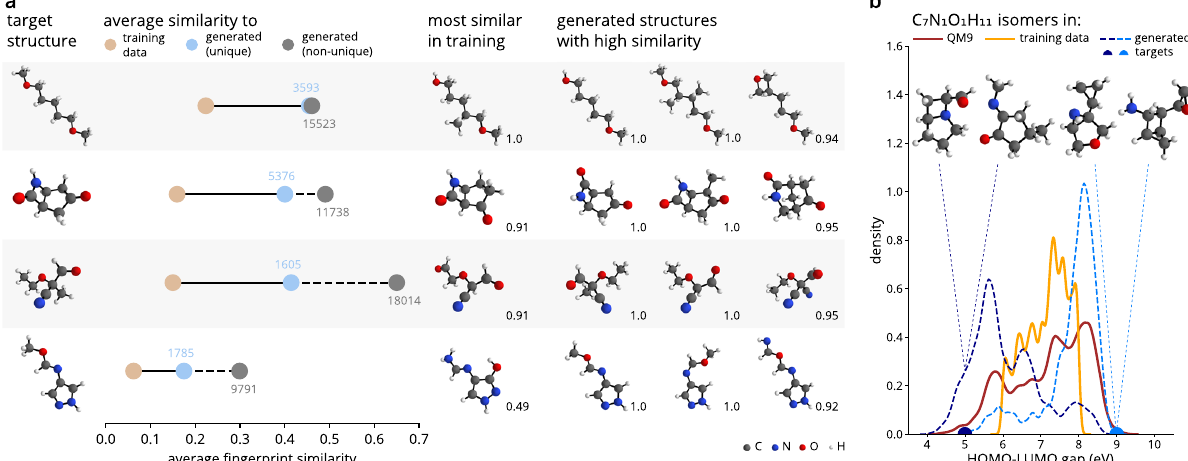
Fig. 3 Targeted exploration of chemical space with cG-SchNet. a Generation of molecules with desired motifs by conditioning cG-SchNet on simple path- based fi ngerprints. First column: Four different target fi ngerprints of structures from the test set. For each, we conditionally sample 20k molecules with cG- SchNet. Second column: Average Tanimoto similarity of the respective target to training structures (brown) and to generated molecules without duplicates (blue) and with duplicates (gray). The amount of generated structures is noted next to the dots. Third column: Most similar training molecule. Fourth column: Three generated unseen examples with high similarity to the target. The Tanimoto similarity to the target structure is noted to the bottom-right of depicted molecules. b Generation of C 7 N 1 O 1 H 11 isomers with HOMO-LUMO gap targets outside the training data range by conditioning cG-SchNet on atomic composition and HOMO-LUMO gap. The training dataset of 55k QM9 molecules is restricted to not contain any C 7 N 1 O 1 H 11 isomers with gap < 6 eV or gap > 8 eV. The graph shows the distribution of the gap for the C 7 N 1 O 1 H 11 isomers in QM9 (brown), the isomers in the restricted training dataset (orange), and the two sets of isomers generated with cG-SchNet (blue curves) when targeting the composition C 7 N 1 O 1 H 11 and two gap values outside the training data range (color-matching dots on the x -axis). For each target value, the two generated isomers closest to it are depicted.